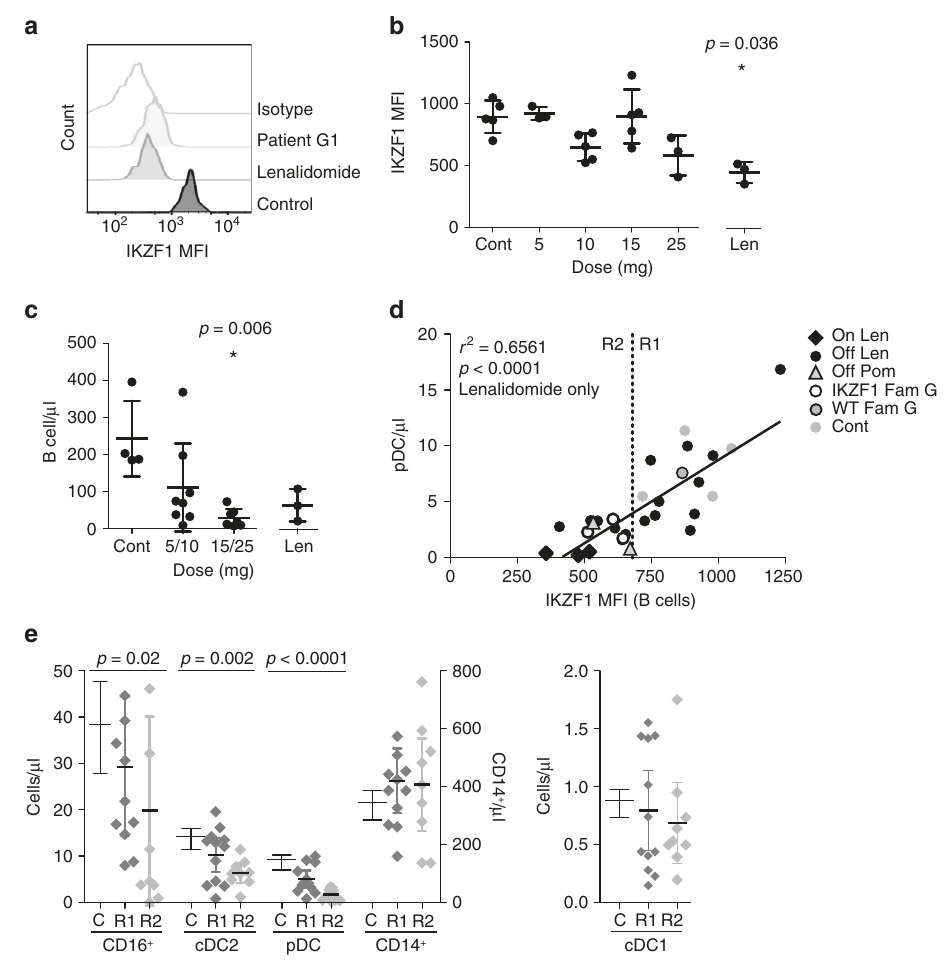
Fig. 3 Dose-dependent reduction of IKZF1 protein and pDCs in patients receiving lenalidomide treatment. a Intracellular fl ow cytometric quanti fi cation (mean fl uorescence intensity (MFI)) of IKZF1 protein levels in B cells (identi fi ed as SSC low Lin − DR + CD2 − cells) of a family G member carrying IKZF1 mutation, patient on lenalidomide treatment, a healthy donor and isotype control. b Intracellular IKZF1 level (MFI) in healthy donors ( n = 5), patients tested at the end of a week off treatment with speci fi ed dose of lenalidomide ( n = 16) (5, 10, 15 or 25 mg daily) and patients taking lenalidomide (Len) on the day of analysis ( n = 3) (15 mg daily). Bars represent mean ± s.d. * p = 0.036 by two-tailed Mann – Whitney U -test versus healthy donor controls. c Summary of absolute B-cell counts in whole blood from healthy donors ( n = 4) (Cont), patients tested at the end of a week off treatment with speci fi ed dose of lenalidomide ( n = 16) (5 or 10, 15 or 25 mg daily) and patients taking lenalidomide on the day of analysis ( n = 3) (15 mg daily). Bars represent mean ± s.d. * p = 0.006 Mann – Whitney U -test versus healthy donor controls. d IKZF1 protein levels (MFI) plotted against absolute plasmacytoid dendritic cell (pDC) counts in affected ( n = 3) and unaffected ( n = 1) members of family G (white or grey open circles, respectively), patients after a week off lenalidomide ( n = 22) (black circles) or taking lenalidomide on the day of analysis ( n = 3) (black diamond) or healthy donors ( n = 4) (grey circles). Data from two patients taking pomalidomide (4 mg daily) are displayed (grey triangles). Black line represents linear regression analysis of lenalidomide-treated patients only. Inclusion of family G members and healthy controls in the linear regression analysis resulted in r 2 = 0.6541, p < 0.0001. Inclusion of pomalidomide- treated patients resulted in r 2 = 0.6419, p < 0.0001. Dashed line represents IKZF1 MFI = 680 dividing group R1 (IKZF1 MFI > 680) from group R2